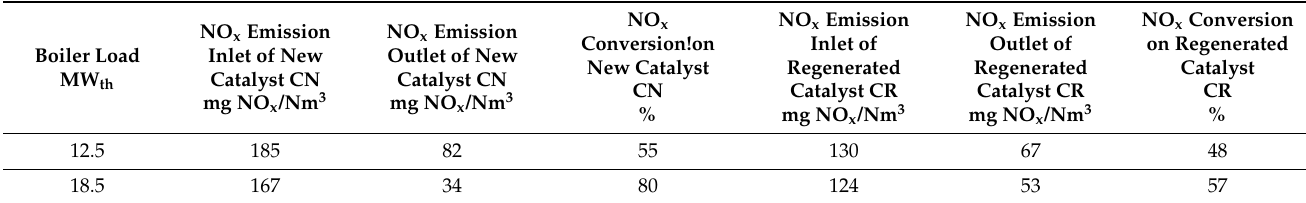
Figure 8. Emissions at the inlet and outlet of the regenerated catalyst CR at an average power of 18.5 MW th -flue gas temperature approx. 300 ◦ C. Table 2. Average NO x emissions and conversion for low and medium boiler